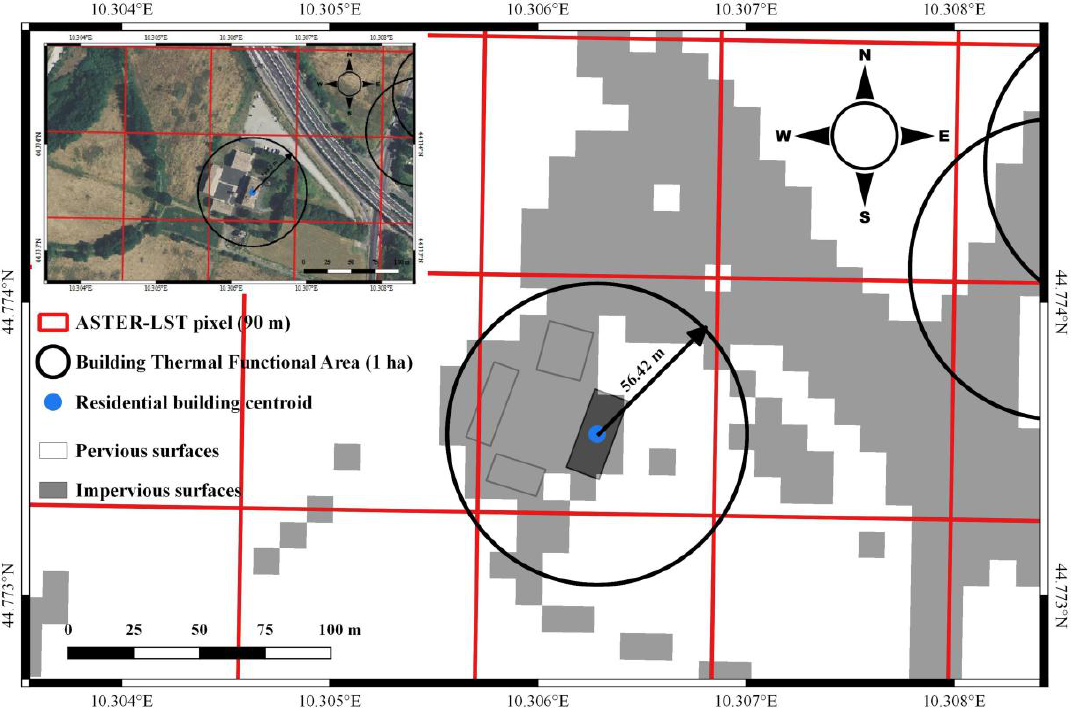
Figure 2. Building Thermal Functional Area (BTFA) framework. The black circle delimits the 1-ha residential BTFA. The blue point is the BTFA center (building centroid). Red squares represent the ASTER-LST pixels (90 m resolution). Impervious and pervious surfaces (10 m resolution) are indicated by grey and white colors respectively.